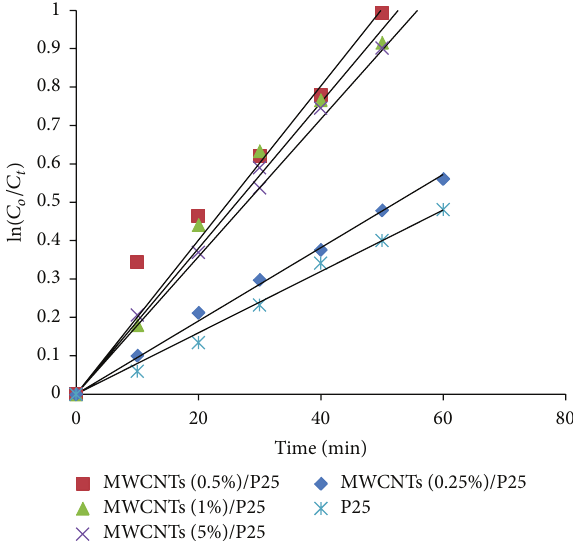
Figure 11: The changes of ln 𝐶 𝑜 /𝐶 𝑡 according to irradiation times at different ratios of the prepared MWCNTs/P25 composite.